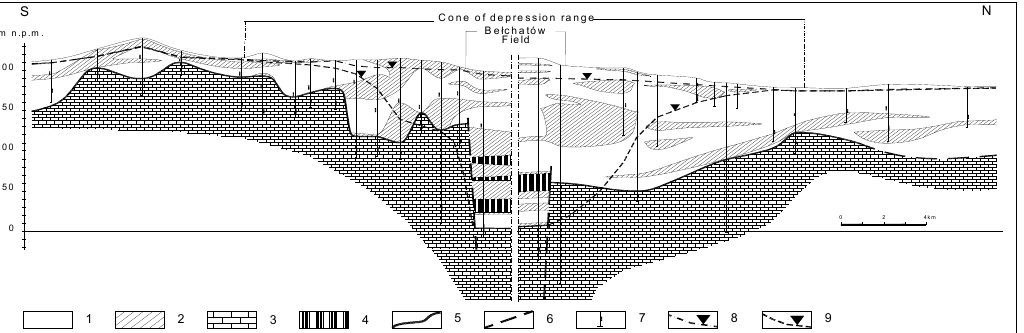
Figure 6. Hydrogeological cross-section through Bełchat ó w Opencast Mine. Explanations: 1 —fine sands; 2 —glacial tills; 3 —limestones, marls and dolomites; 4 —lignite; 5 —stratigraphic boundary; 6 —faults; 7 —screened intervals of a weeks; 8 —ground water level in pre-mining conditions; 9 —ground water level in mining conditions [57].